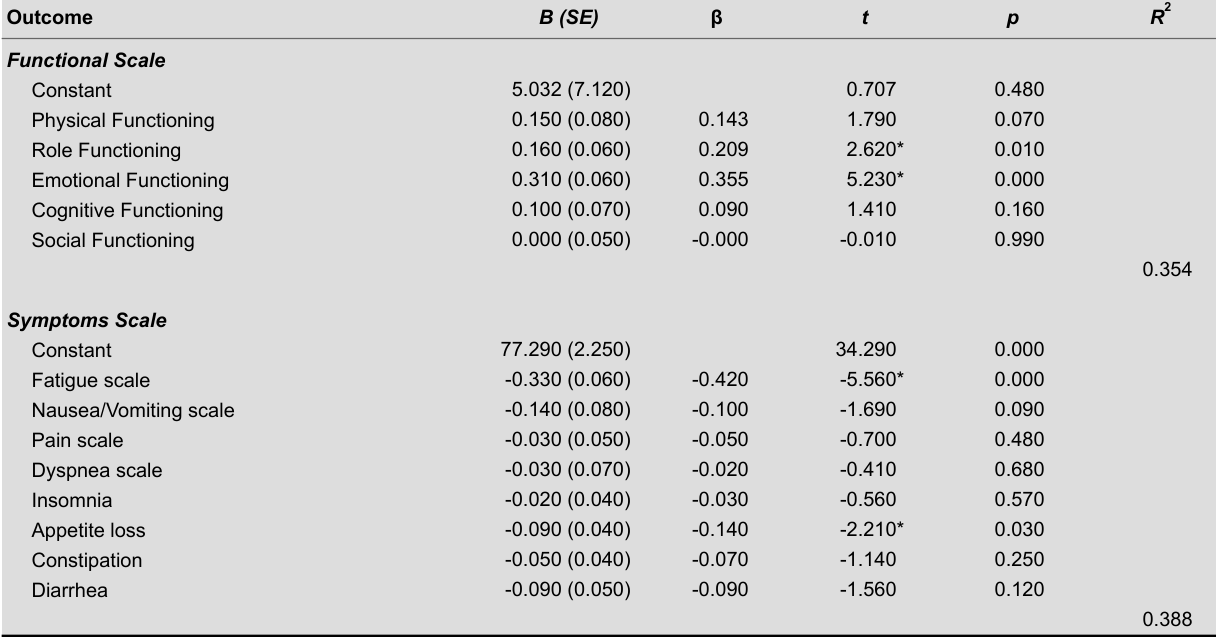
EORTC QLQ-C30 Functioning and Symptoms Scales as Predictors of Quality of Life